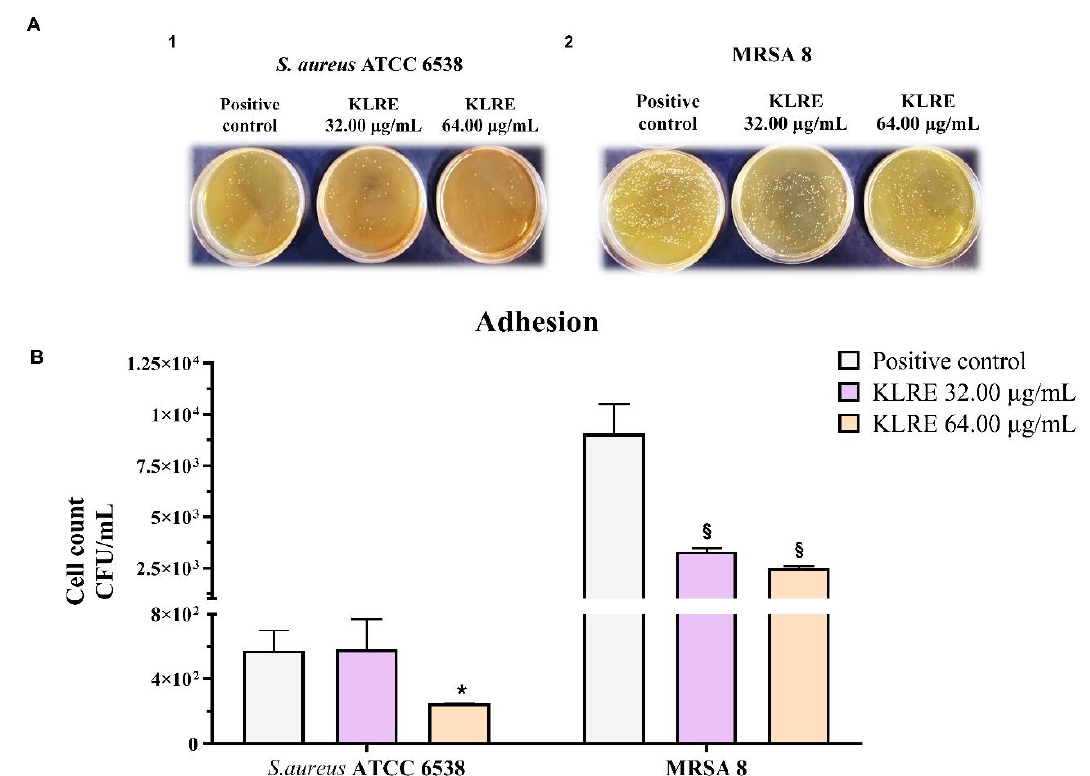
Figure 6. Effect of K. lappacea root extract (KLRE) on the adhesion of S. aureus ATCC 6538 and MRSA 8 to human lung A549 cell line. ( A 1, A 2). Representative photographs of plate bacterial count. ( B ). Quantitative analysis of bacterial adhesion to A549 cells. Light grey histograms: A549 cells infected with S. aureus ATCC 6538 or MRSA 8 strains (positive controls). Violet histograms: A549 cells infected with standard or clinical strains and simultaneously treated with 32.00 µ g/mL of KLRE. Pink histograms: A549 cells infected with standard or clinical strains and simultaneously treated with 64.00 µ g/mL of KLRE. The values are expressed as colony-forming unit mL − 1 (CFU/mL). The bars represent means ± SD of three independent experiments performed in triplicate (SD = standard deviation). Statistically significant differences, determined by one-way analysis of variance ANOVA, are indicated: * p ≤ 0.05, § p ≤ 0.0001 versus positive control.